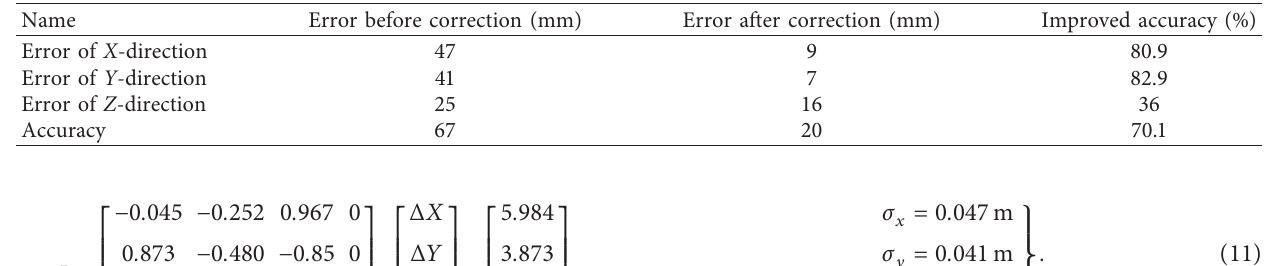
Table 7: Comparison of position accuracy.